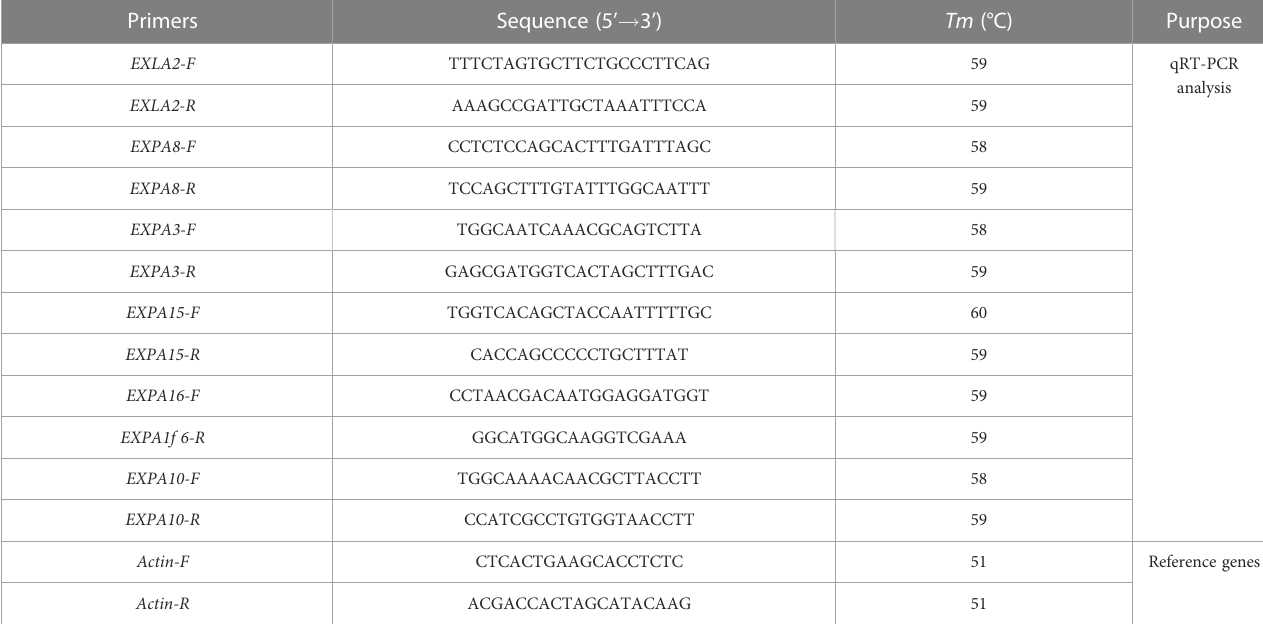
TABLE 1 Primers used for quantitative real-time PCR analysis.